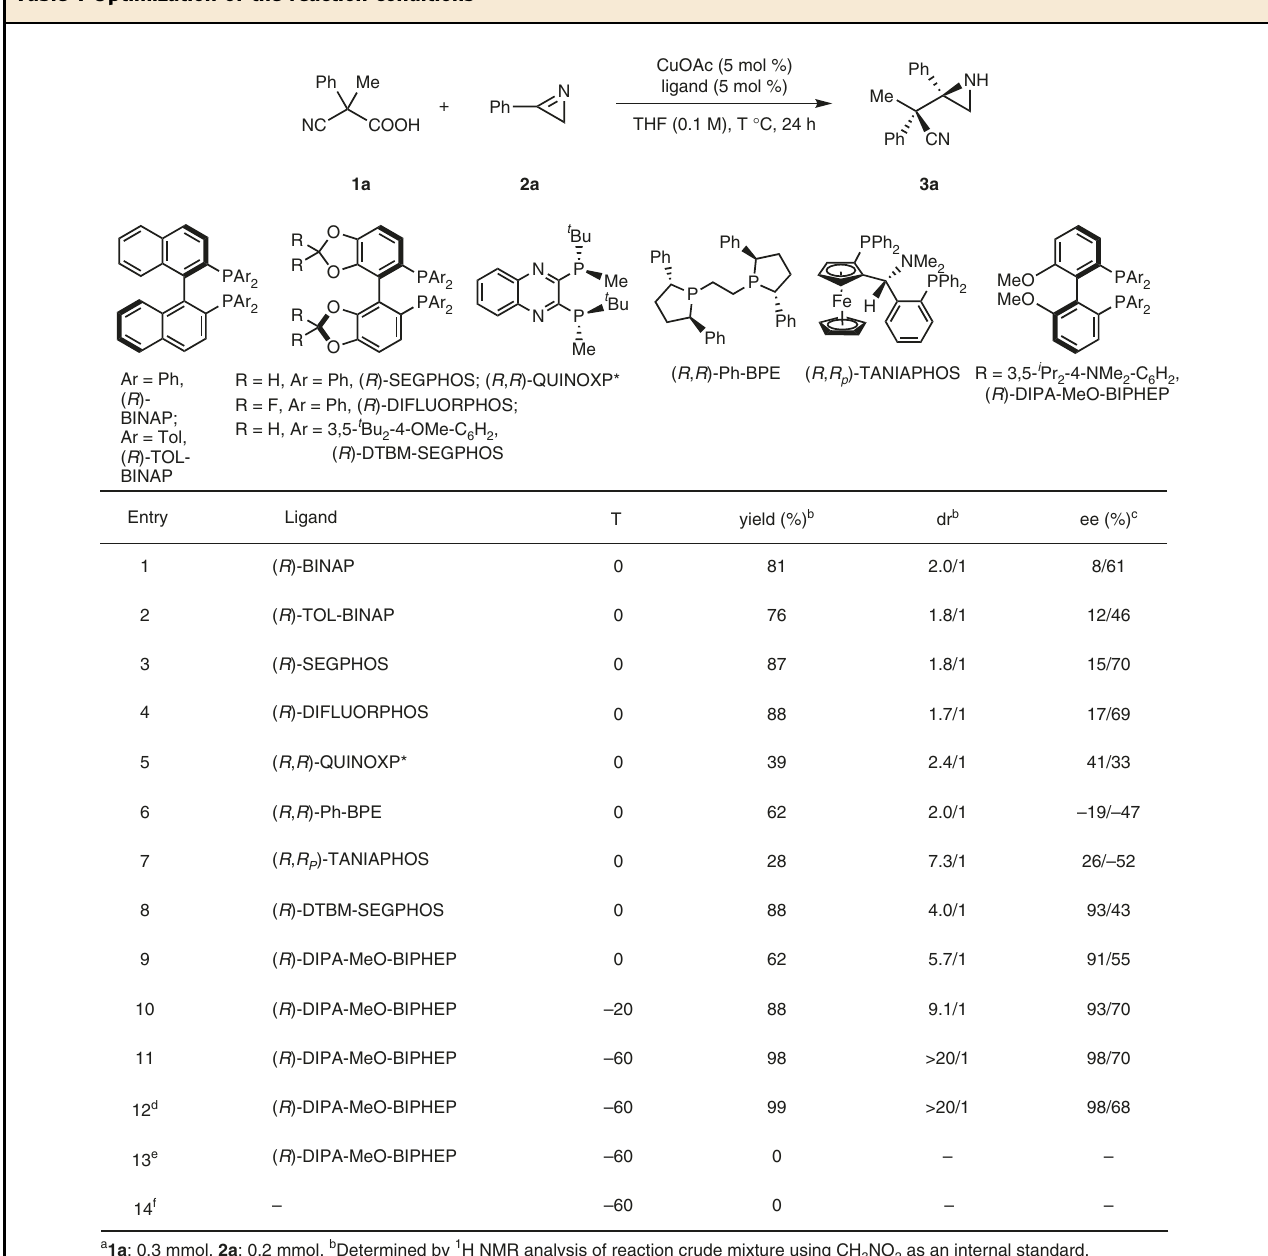
Table 1 Optimization of the reaction conditions